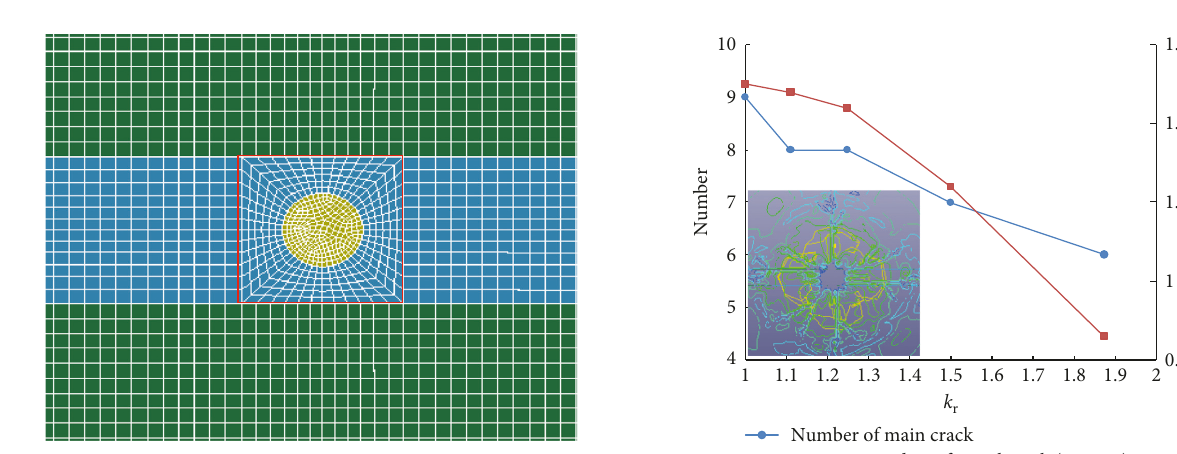
Figure 6: Larger image of grid around the blasting